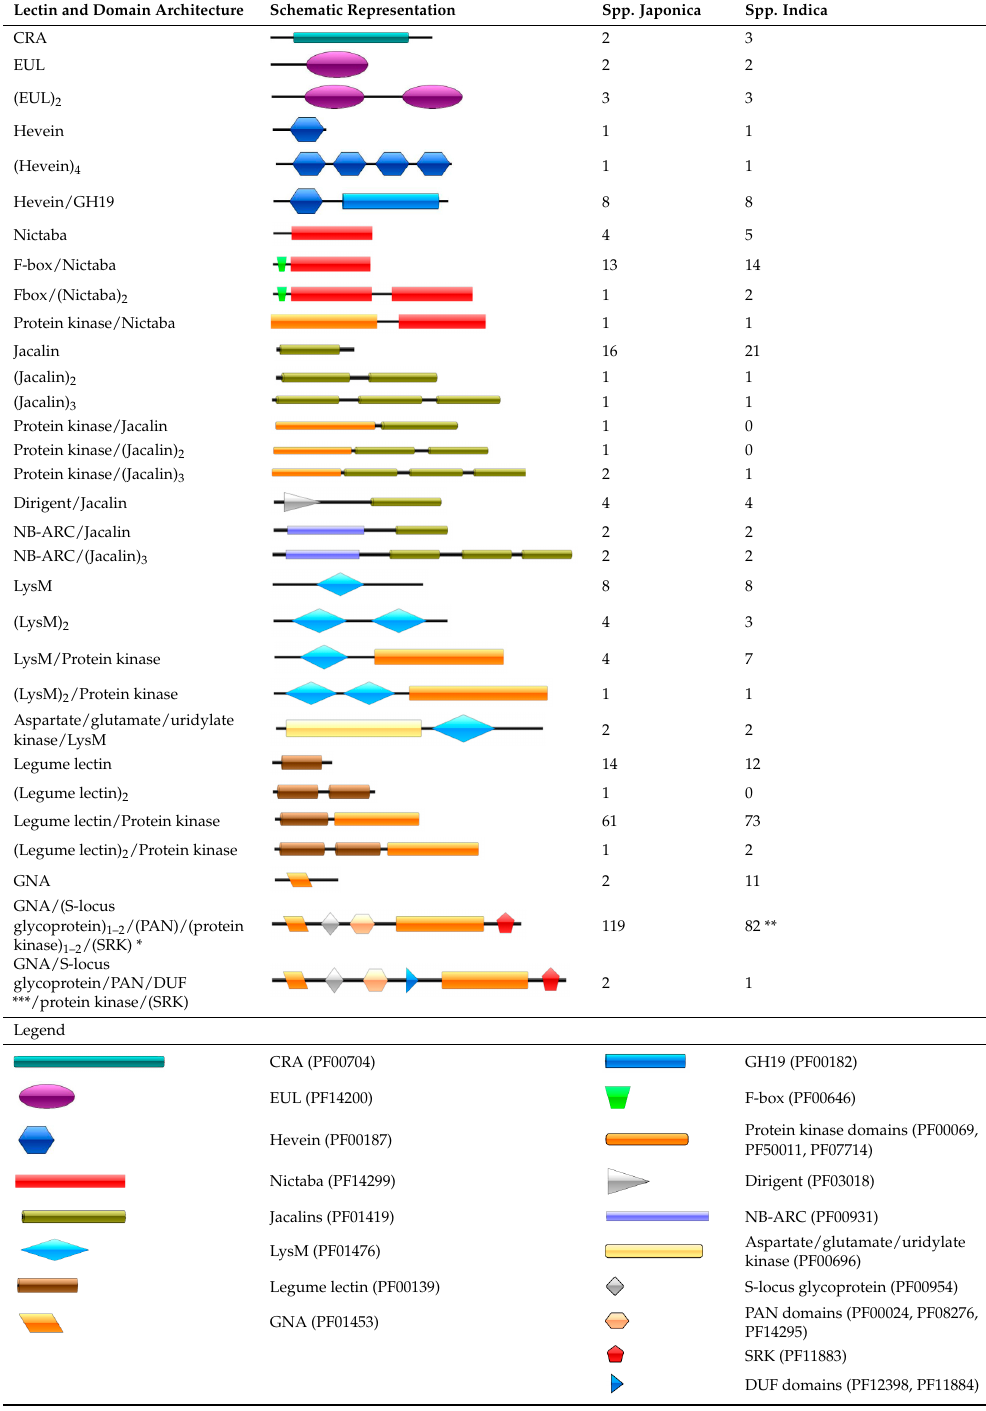
Aspartate / glutamate / uridylate kinase/LysM